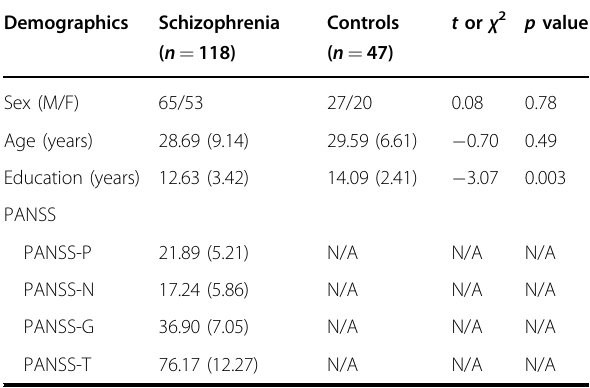
schizophrenia patients and healthy